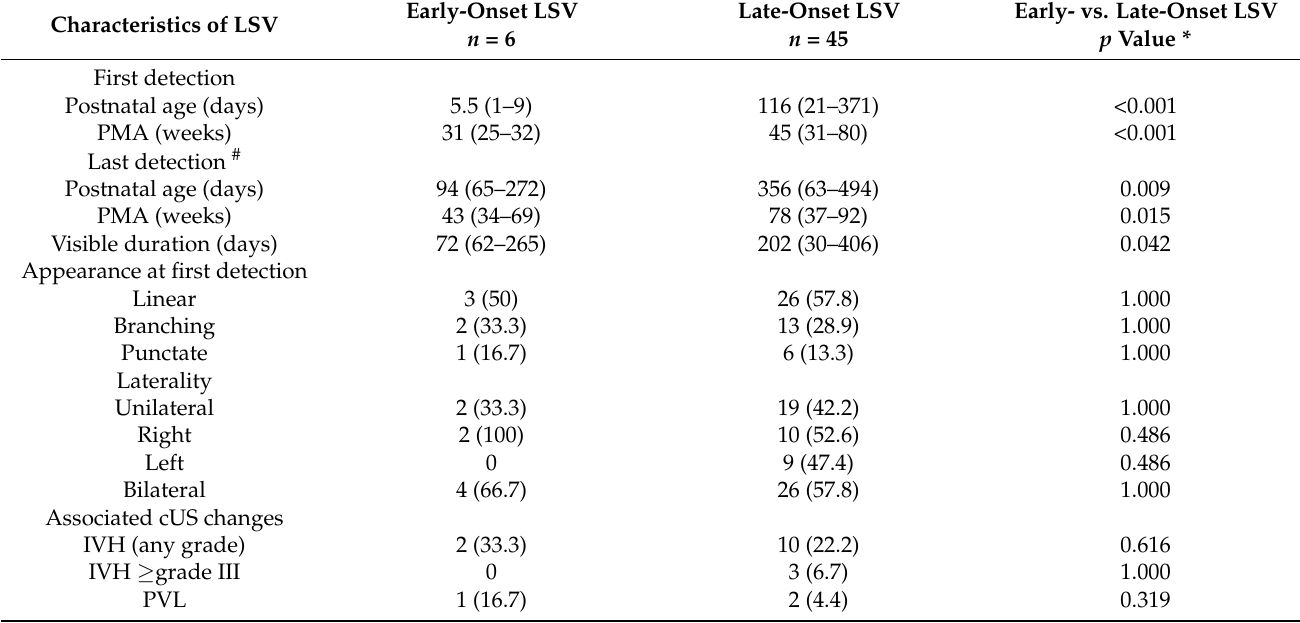
Table 1. Presentations and evolution of LSV in very-low-birth-weight preterm infants.